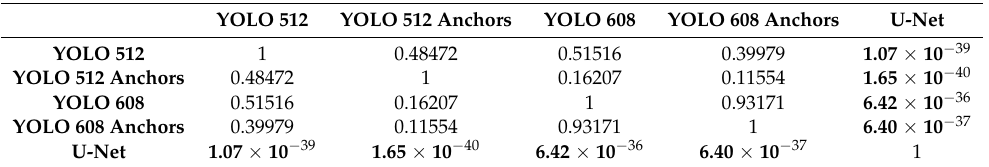
Table A2. McNemars’ test for image-based evaluation of the methods. Bolded values represent statistical significance at the p < 0.01 level.